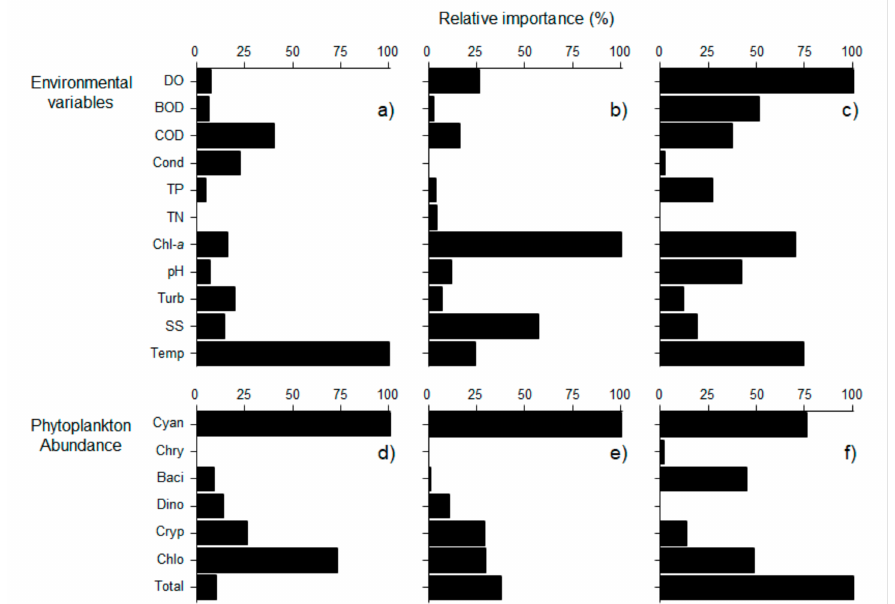
Figure 7. Relative importance (%) of environmental variables ( a – c ) and phytoplankton abundance ( d – f ) in predicting category with highest geosmin concentration (D) in three different depths. Surface layer ( a , d ), Middle layer ( b , e ), and, Bottom layer ( c , f ). Abbreviation of each variable indicated in Table